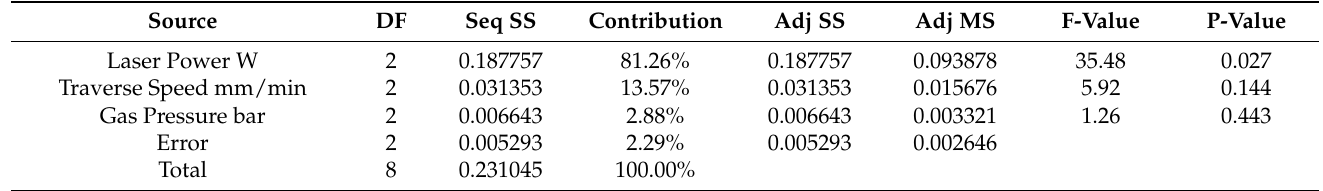
Table 15. ANOVA table for kerf taper angle response of input cutting parameters of 6 mm thickness of SPF-UPE composite cut by the laser beam cutting